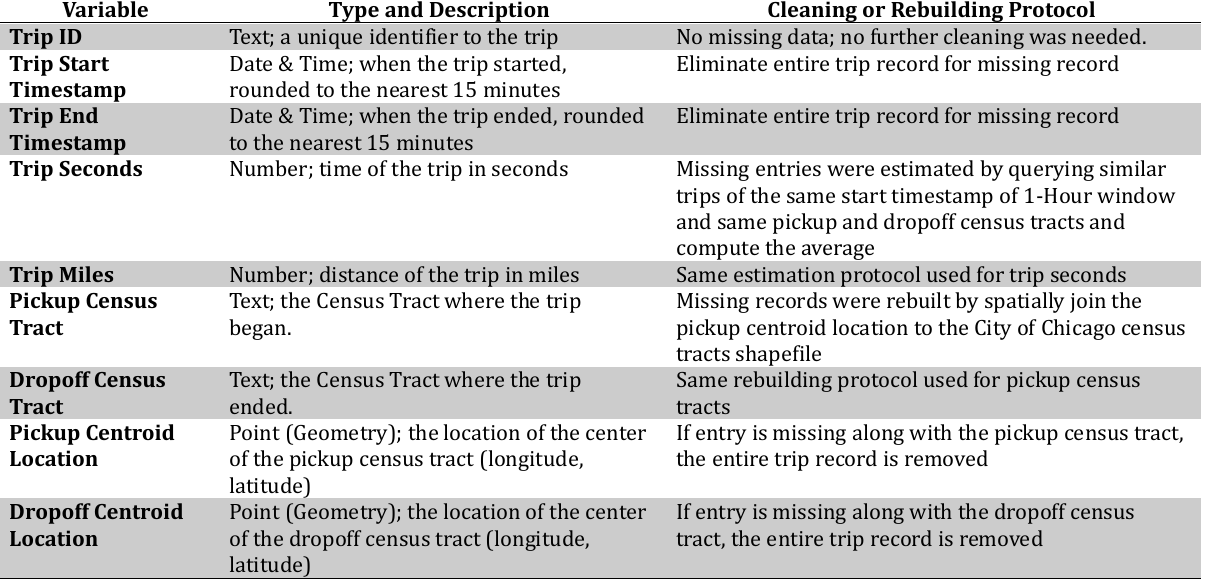
Table 1: City of Chicago TNC Trip Dataset- Key Variables